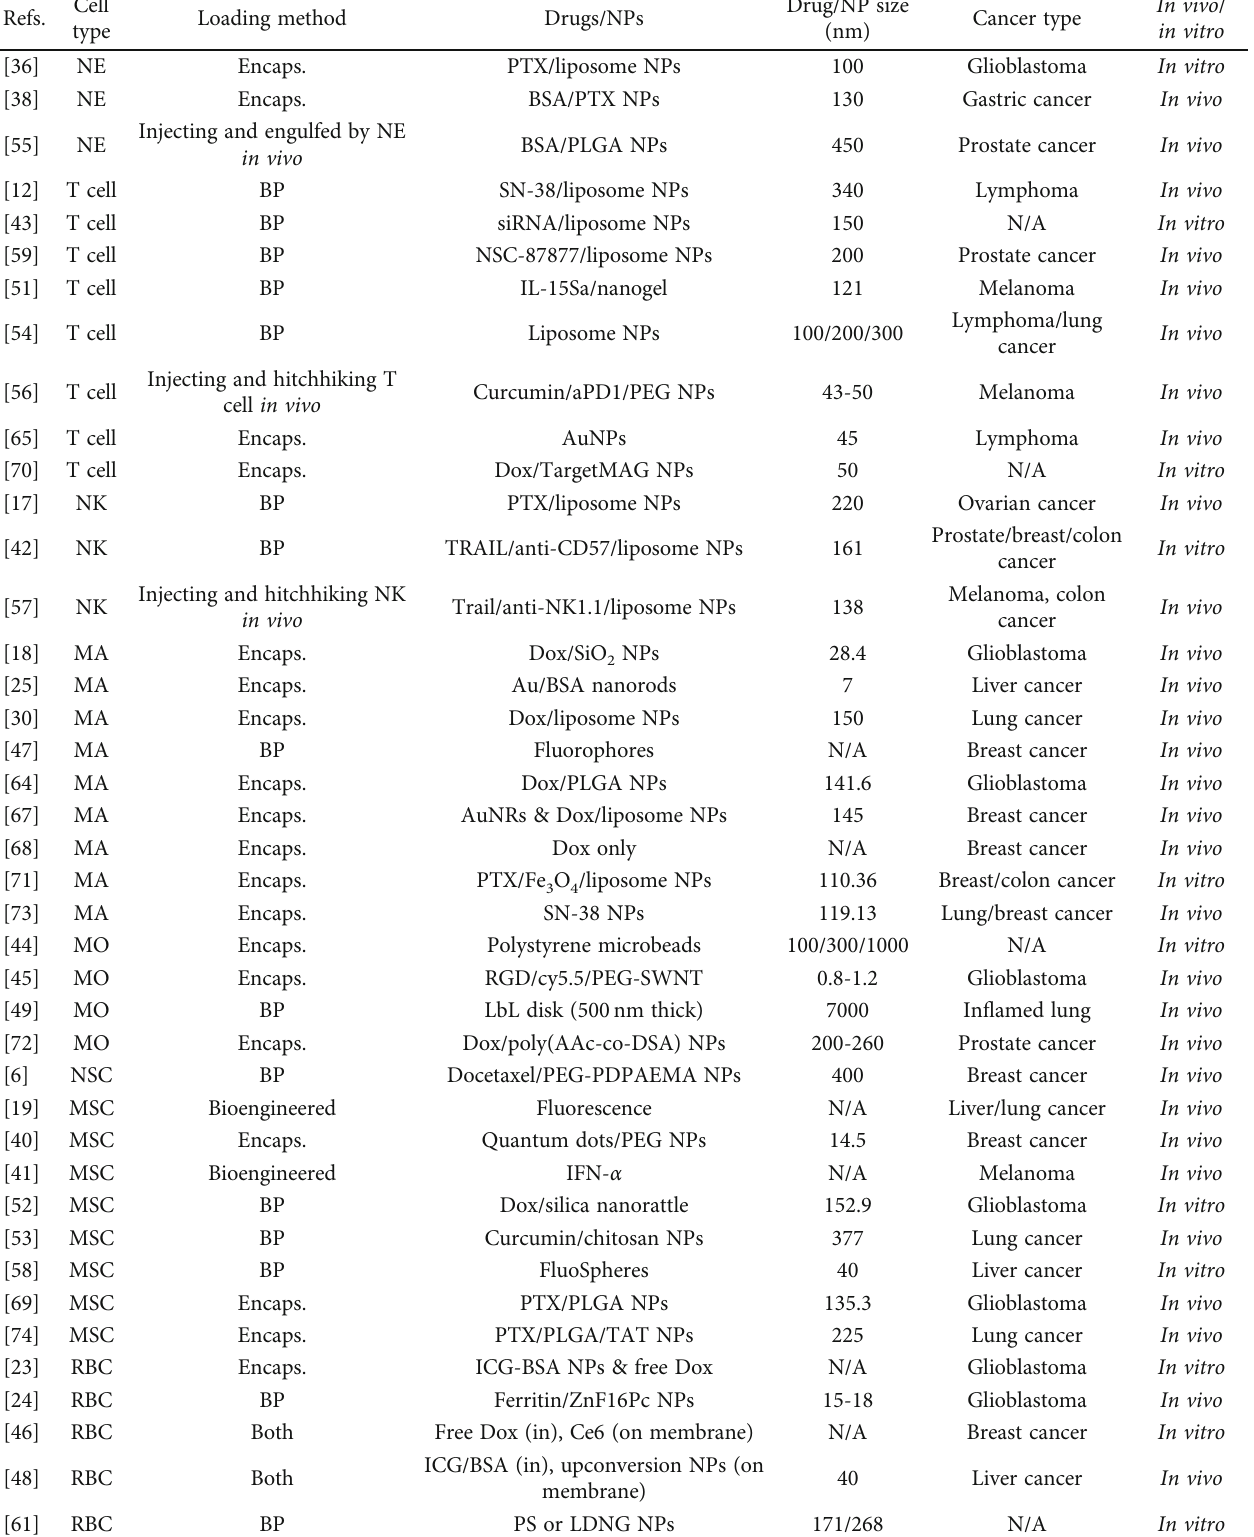
Table 3: Di ff erent cells loaded with varied cargos for cancer diagnosis and therapy.